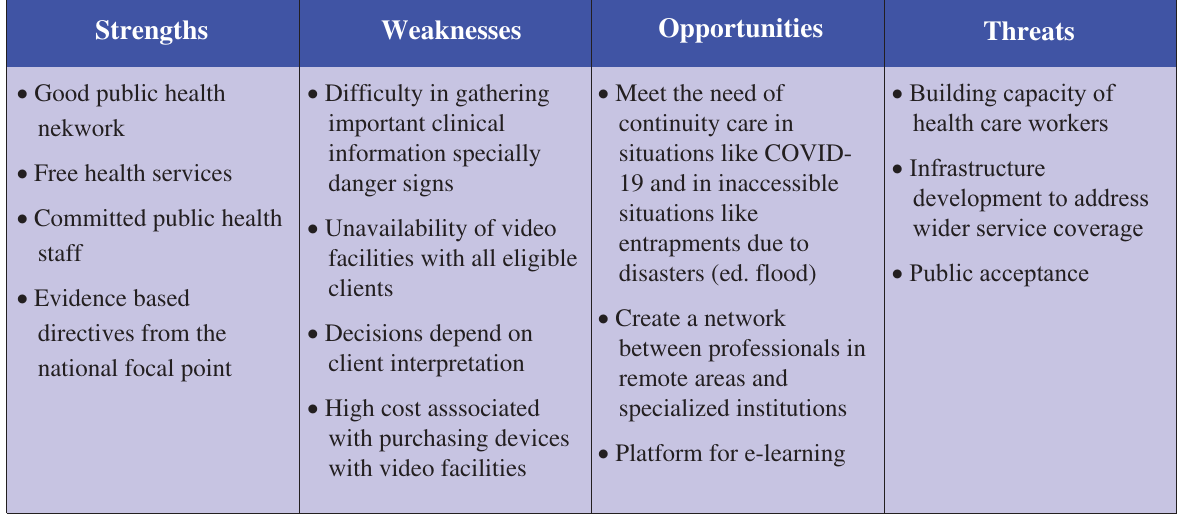
Figure 2: SWOT analysis of continuity of care through